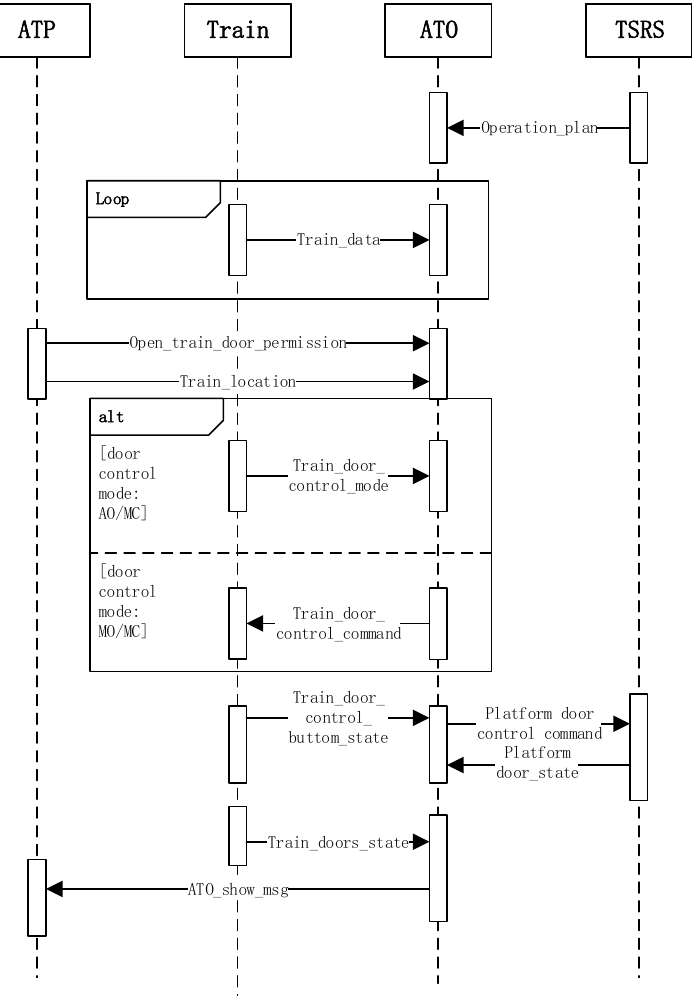
Figure 11. Interaction process of the